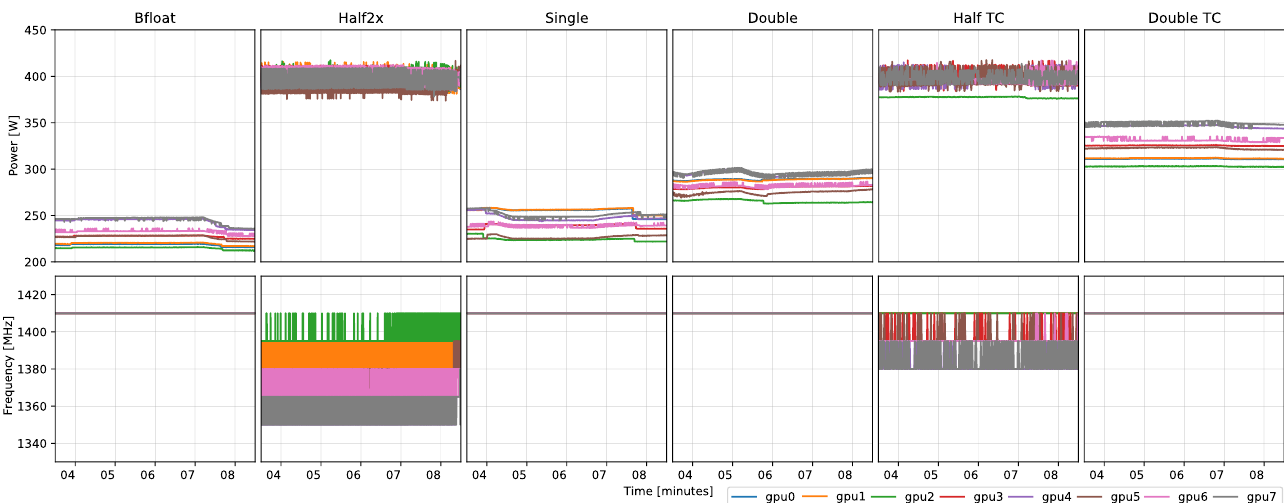
Figure 7. Power consumption variation of all the GPUs in the DGX-A100 when under full load using compute bound workload with six different